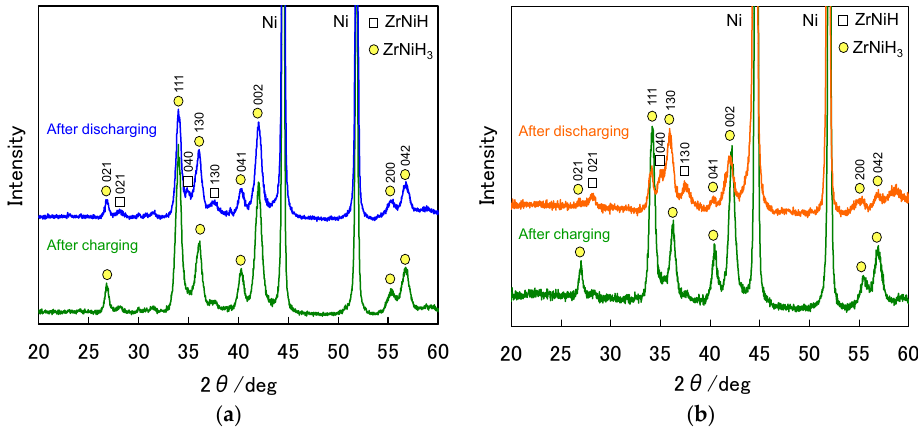
Figure 4. The X-ray diffraction (XRD) profiles after charging and discharging for the ZrNi electrodes: ( a ) without and ( b ) with the boiling alkaline treatment for 4 h.